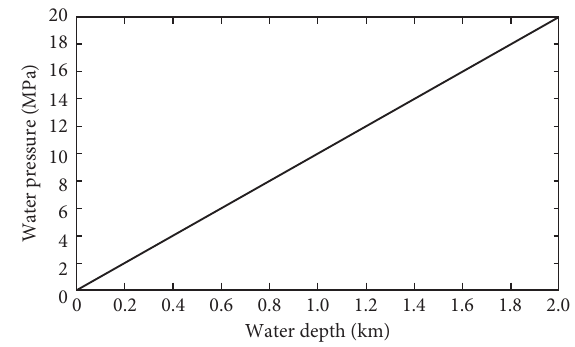
Figure 1: Seawater pressure with